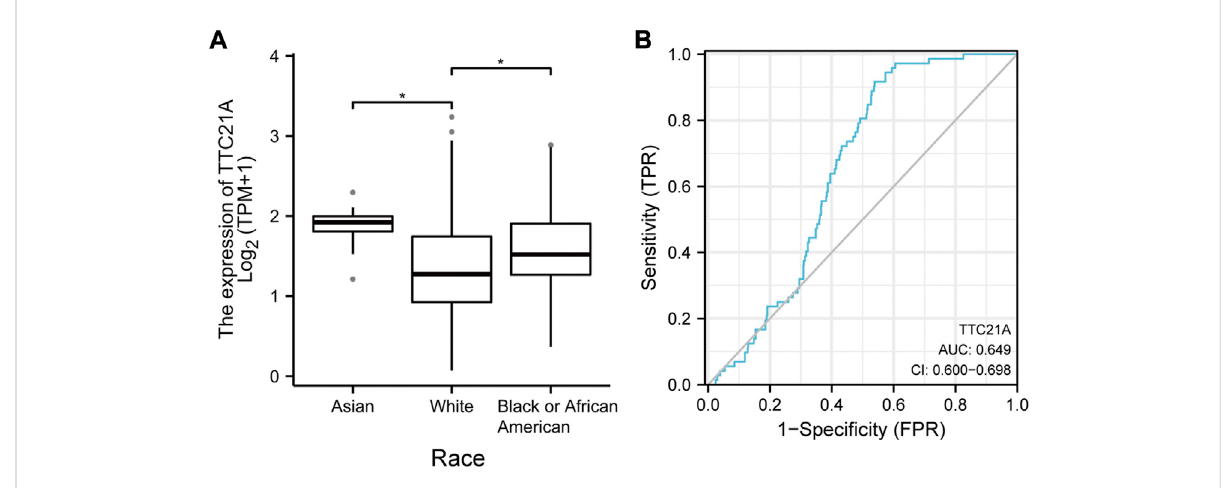
FIGURE 2 Correlation ofTTC21Aandclinicopathologic characteristicsinccRCC. (A) TTC21Aexpressionwasassociatedwithdifferentraces(* p < 0.05)